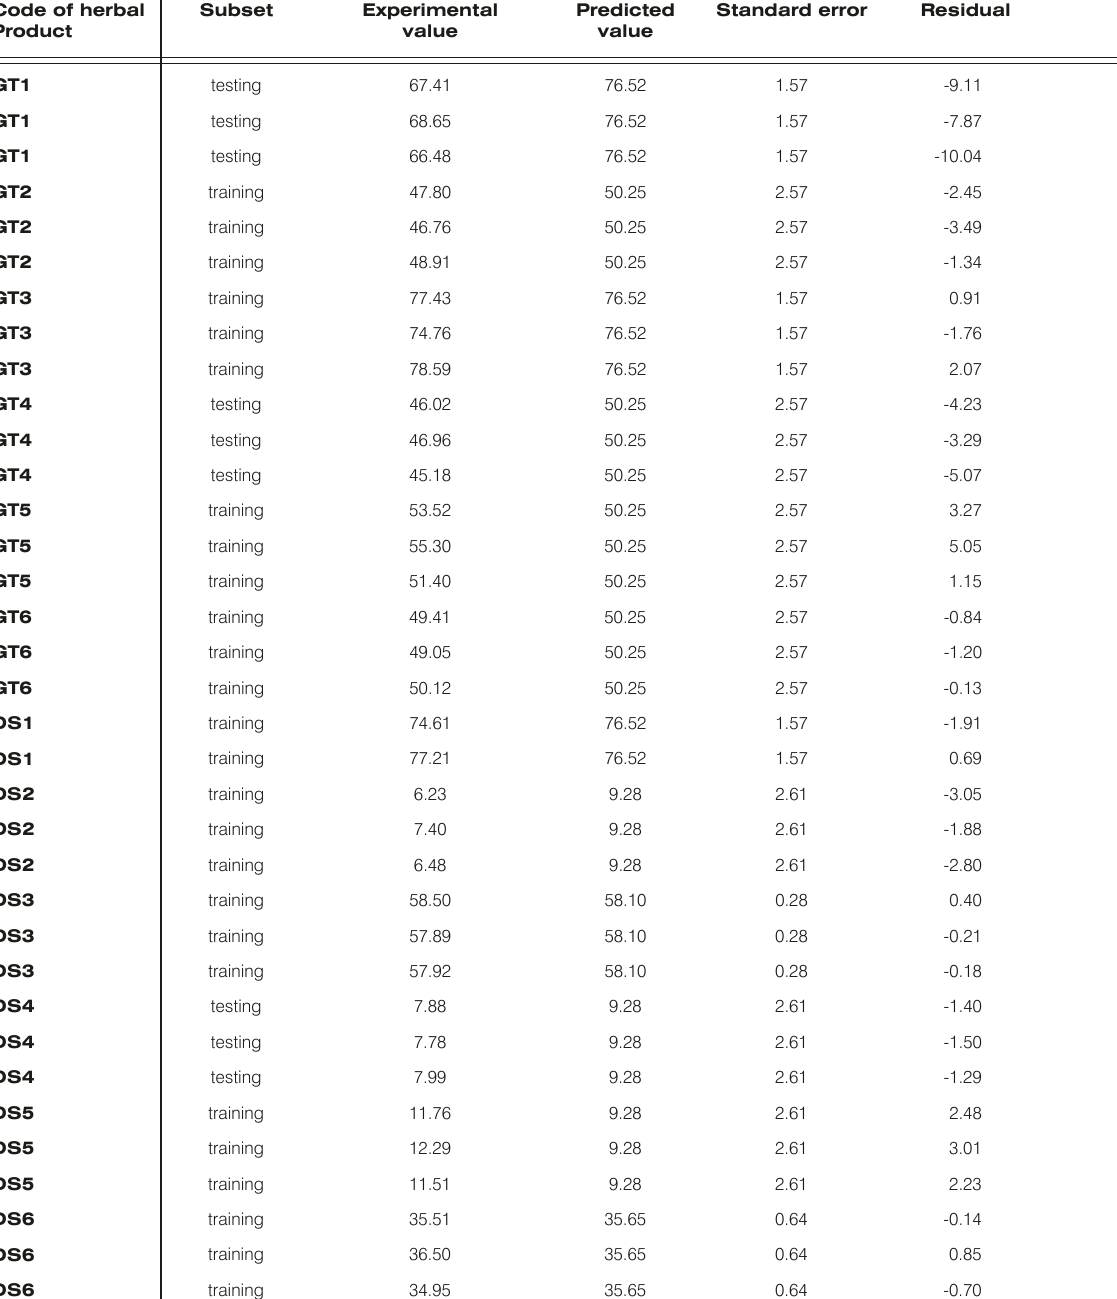
Table 3. Summary table collecting the samples with experimental and predicted data for training and testing subsets. Code of herbal